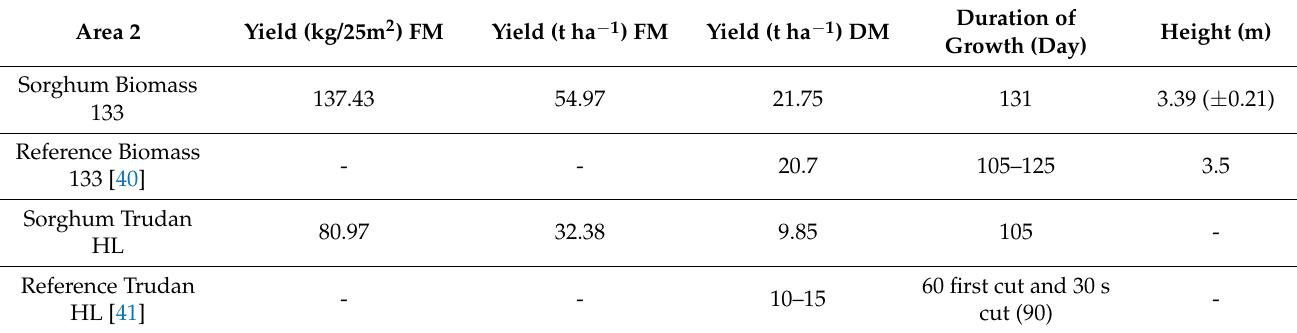
Table 3. Biomass yield, growth duration, and height of sorghum in area 2, FM: fresh matter, DM: dry